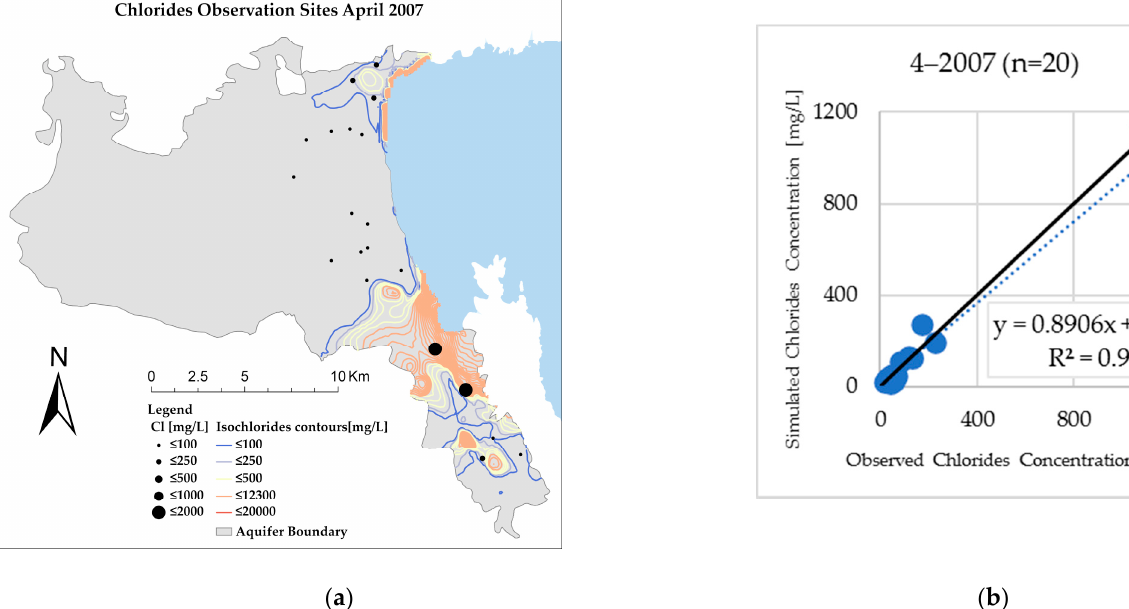
Figure 22. ( a ) Isochlorides contours for April 2007 and ( b ) scatterplot of simulated against observed chloride concentration values.